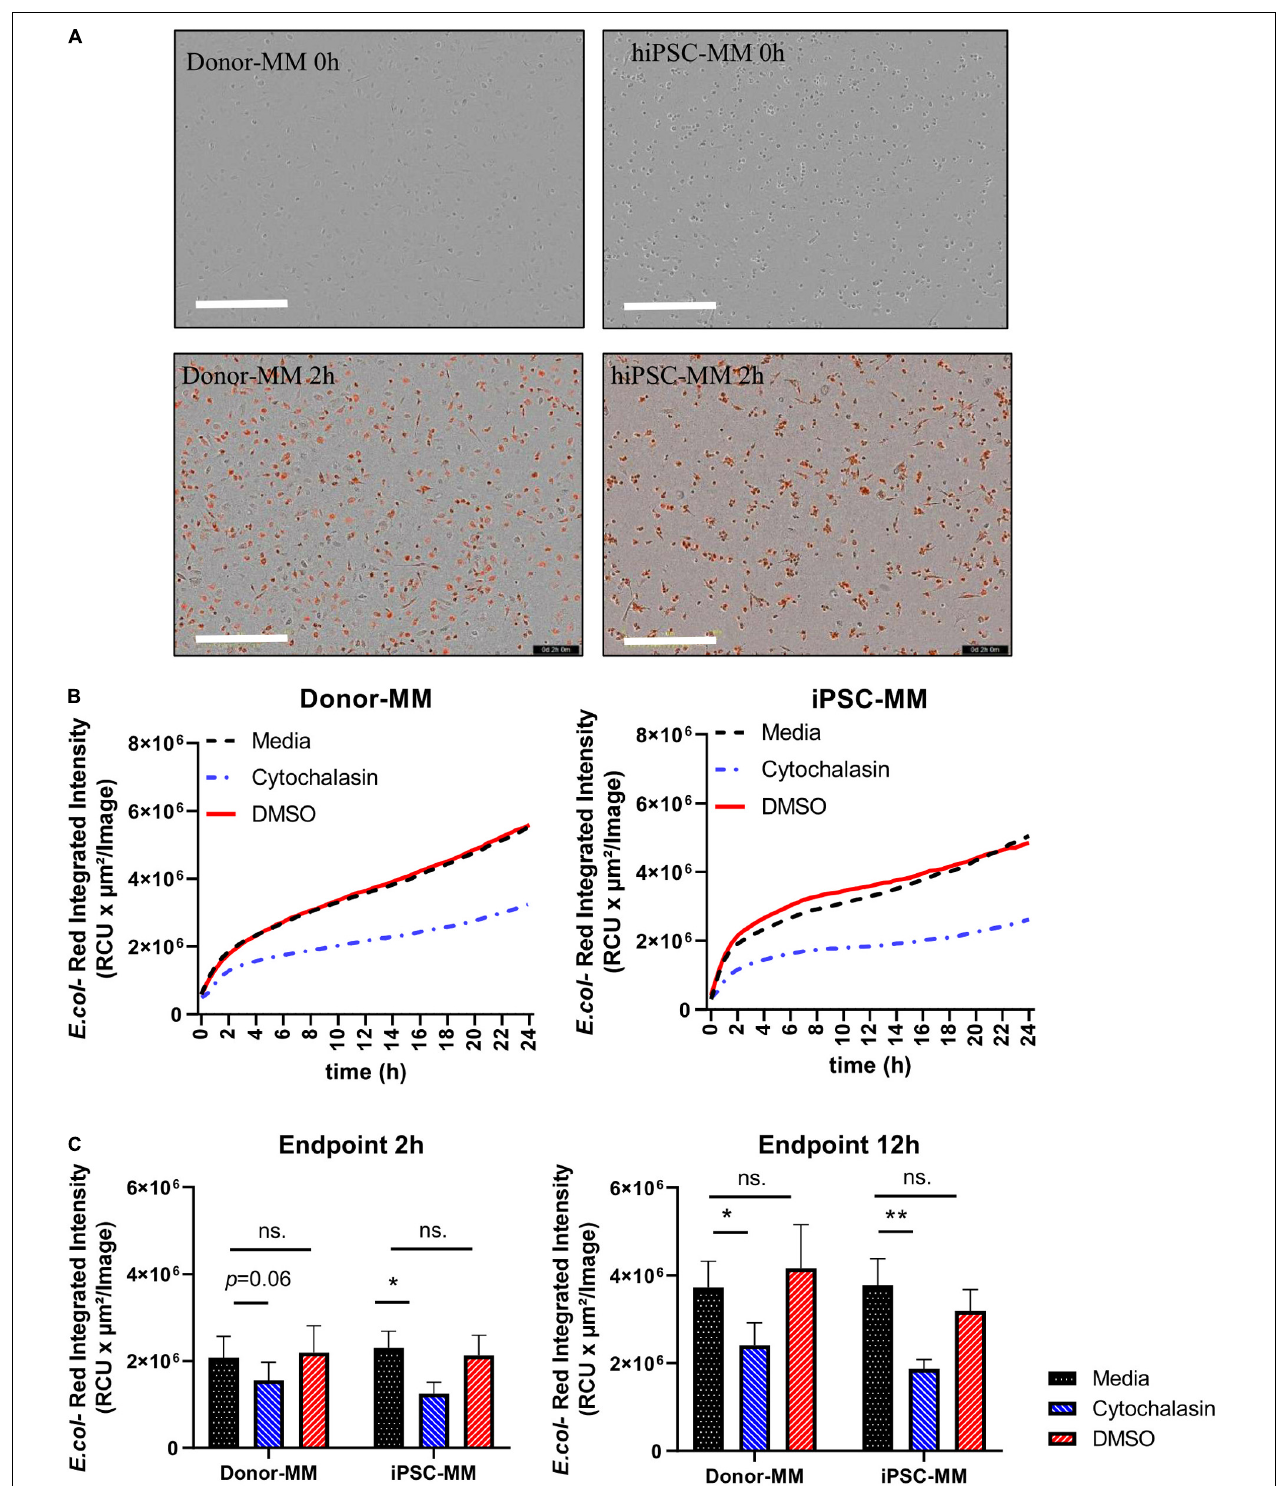
FIGURE 4 | Functional comparison of macrophages differentiated from human induced pluripotent stem cell (hiPSC)-derived and donor-derived monocytes. (A) Representative images of Escherichia coli -Red uptaking in phagocytosis assay at time points of 0 and 2 h. Scale bar represents 400 µ m. (B) Real-time graph of E. coli -Red integrated intensity from 0 to 24 h under conditions of medium, cytochalasin, and dimethyl sulfoxide (DMSO) groups in hiPSC and donor groups ( n = 4). (C) Analysis of phagocytosis assay at time points of 2 and 12 h in hiPSC and donor groups. Two-way ANOVA with Bonferroni correction for multiple comparison: * p < 0.05, ** p <